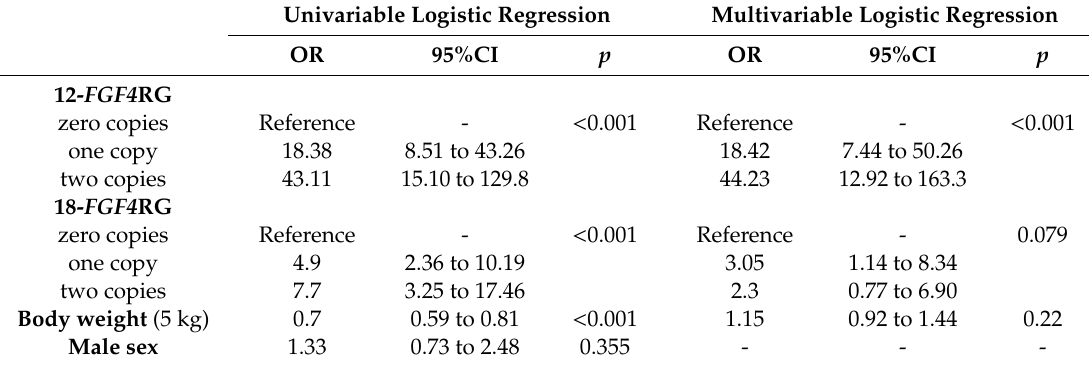
Table 5. Logistic regression analysis of factors associated with IVDD surgery in 506 mixed breed dogs (46 surgical cases and 460 non-surgical). All non-surgical cases were at least 10 years of age at their